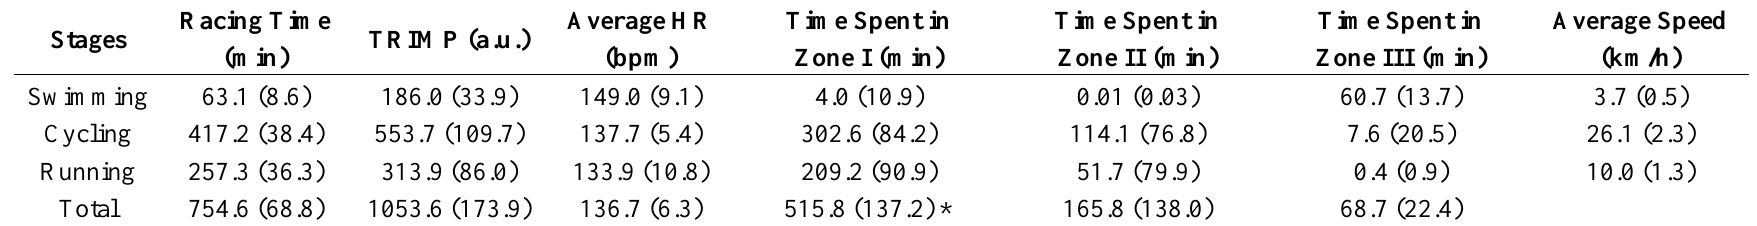
Table 1. Swim, cycle, run and overall variables during the ultra-endurance triathlon race.